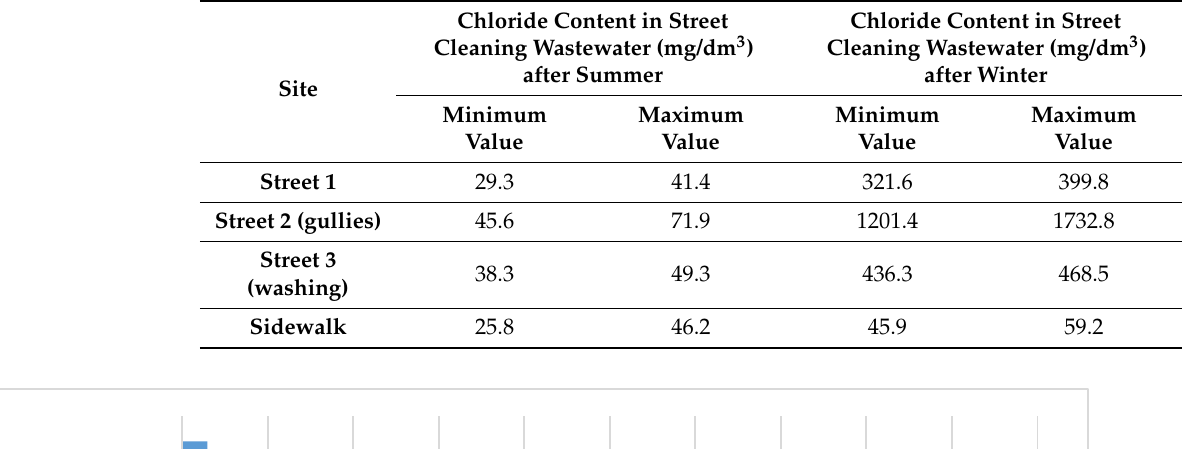
Table 1. Chloride content in individual street and sidewalk cleaning samples after summer and